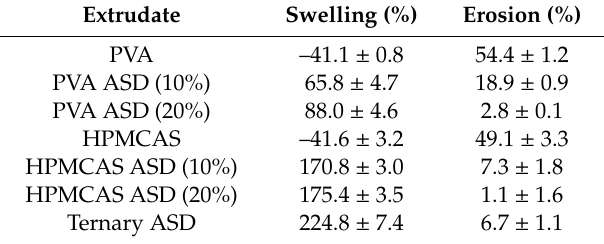
Table 1. Degree of swelling and erosion of placebo extrudates and ASDs ( n =